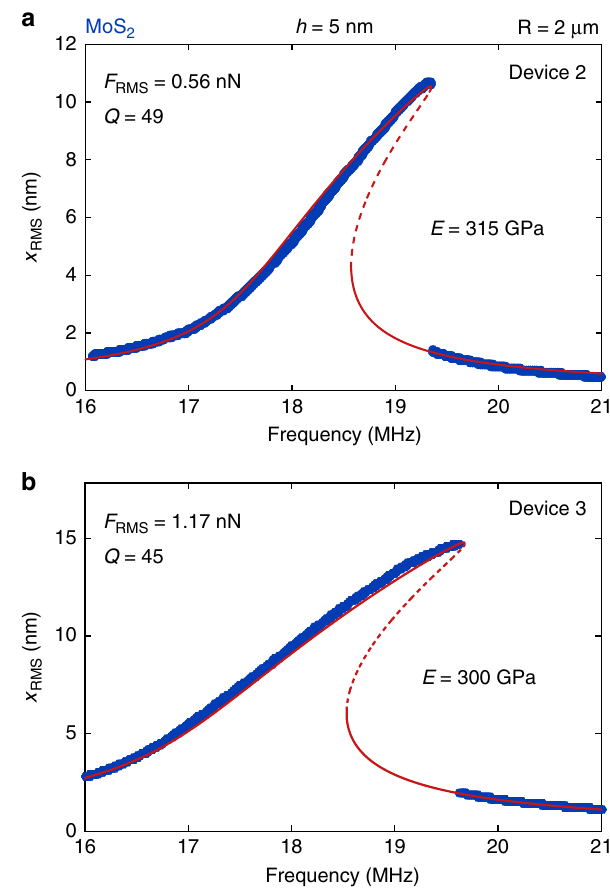
Fig. 5 Measurements on two MoS 2 drums. Measurements (blue dots) and fi ts (drawn red curves: stable solutions; dashed red curves: unstable solutions) of two 5 nm-thick-MoS 2 drums with Young ’ s moduli of: a device 2: 315 GPa and b device 3: 300 GPa